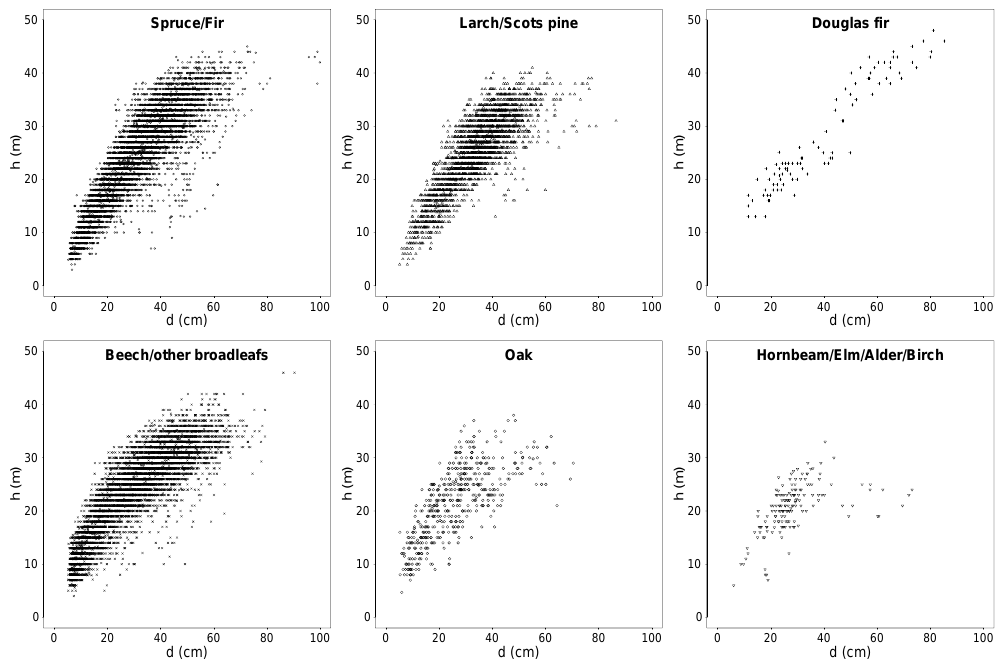
Figure A1. Smoothed scatterplots of the observed height – diameter pairs for the different tree species of the model dataset.